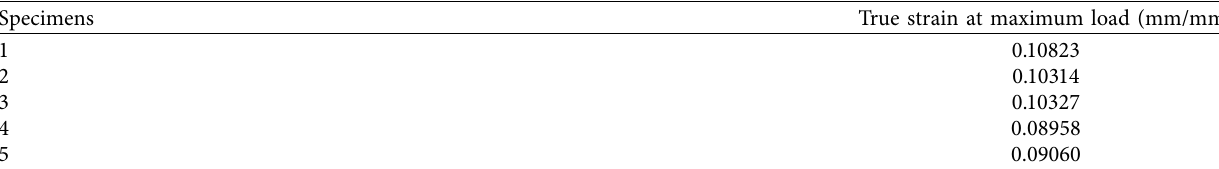
Table 3: True stain of tensile specimens.